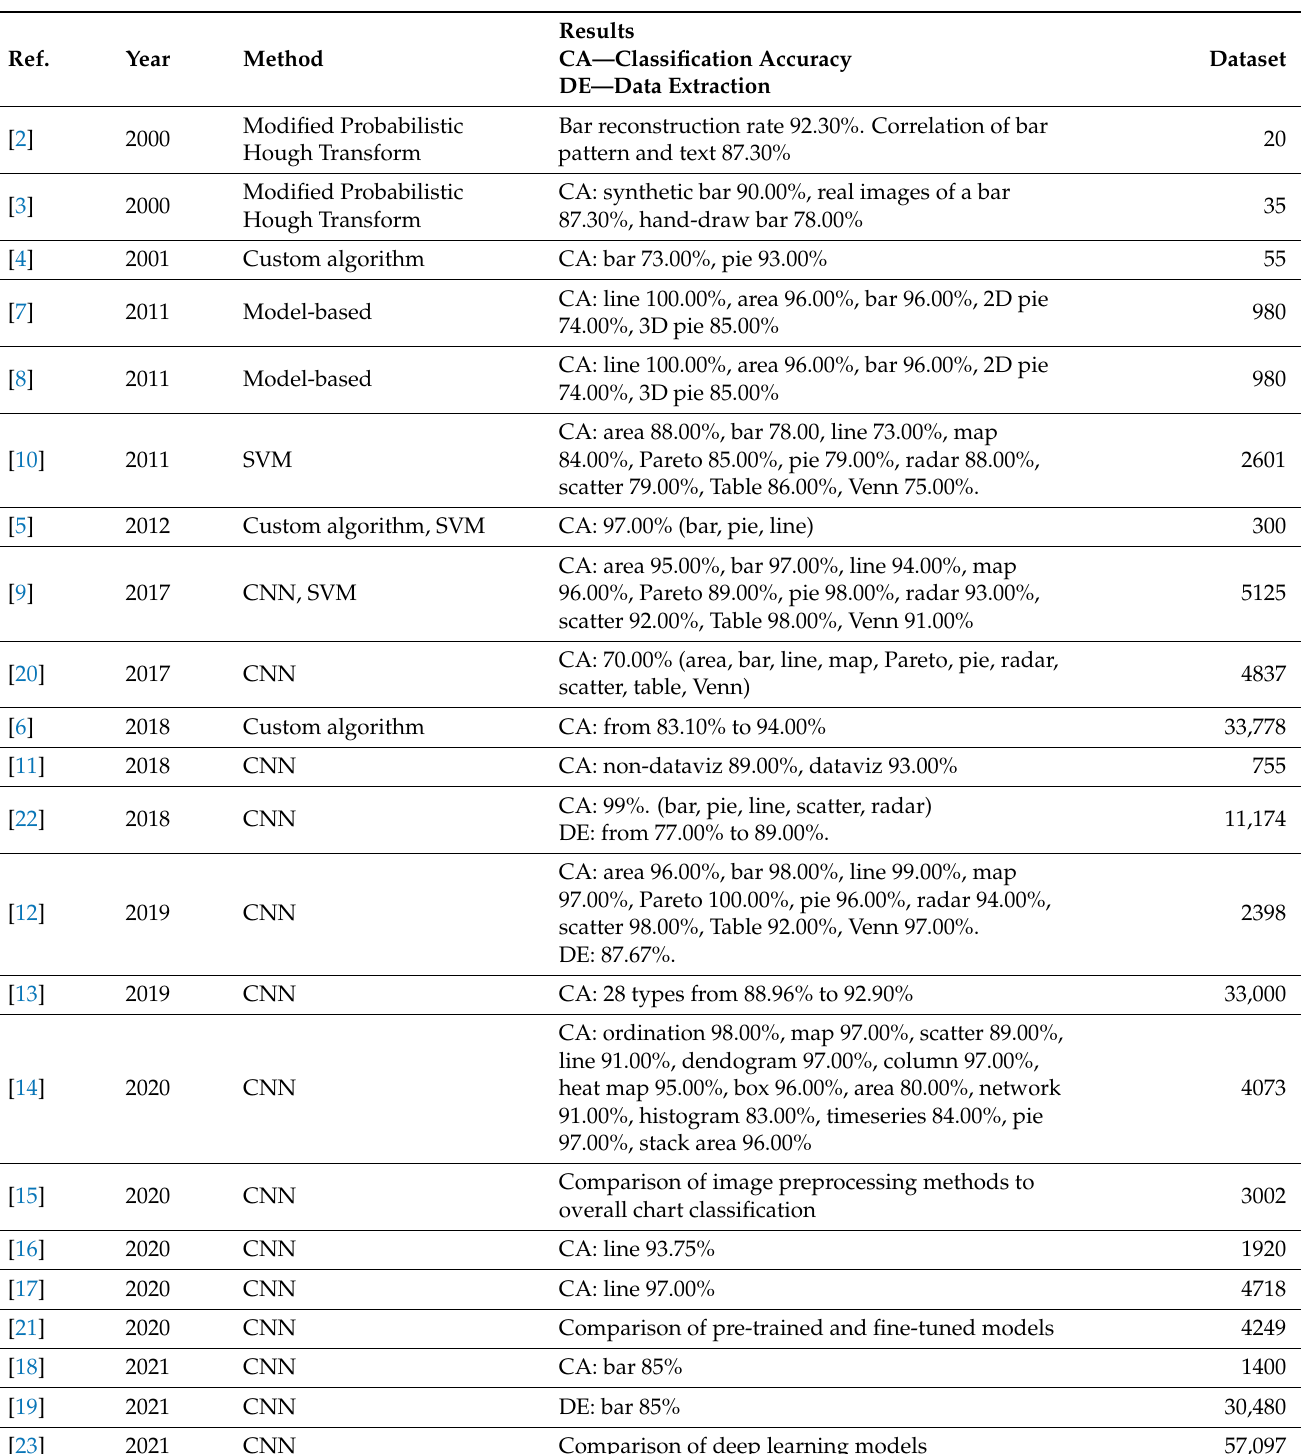
Table 1. A short summary of a presented related